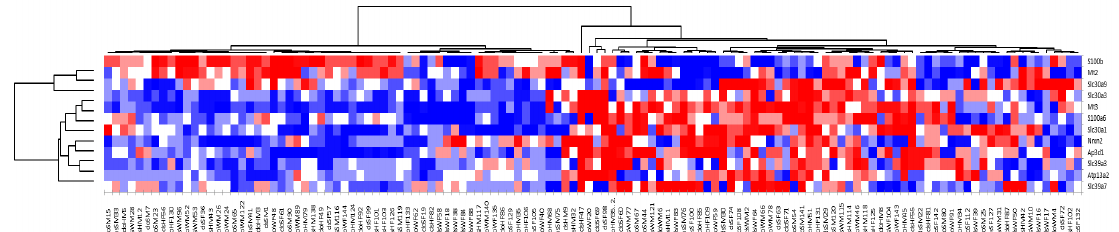
Figure 2. Gene expression profile clustering based on the 11 genes that differentiate animal groups A and B. Genes are shown as rows, and animals (dentate gyrus samples) are shown as columns. The expression changes in the heat map are represented by z -scores that are color-coded according to their values: red squares correspond to positive changes in expression levels (upregulation); blue squares correspond to negative changes in gene expression (downregulation); and white represents the absence of changes.